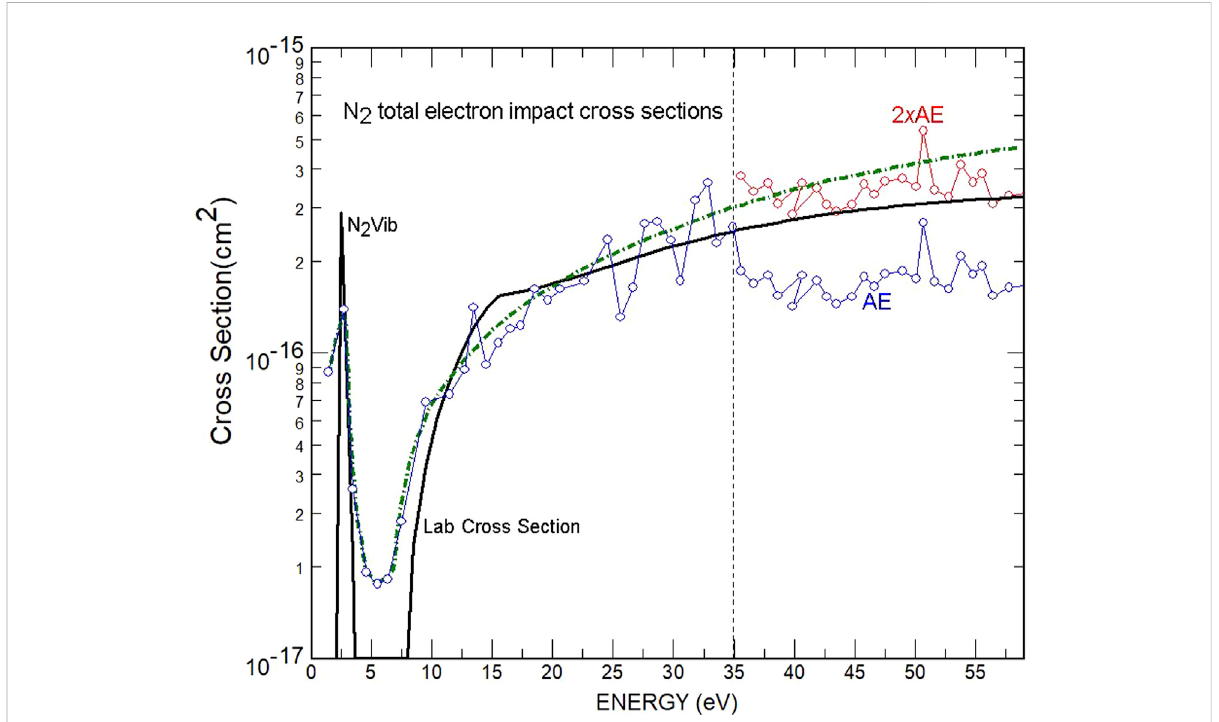
Comparison of N 2 cross-sections derived from Atmosphere Explorer solar EUV irradiance and photoelectron fl ux (AE) with Laboratory cross- section(solid line). Thedash-dotlineisaweightedleast-squares fi ttothe1.0xAEdata points below35 eV. Thepoints labeled2 x AEwereobtained by doubling the AE values. The label N 2 Vib identi fi es the cross-section peak near 2.5 eV that results from vibrational excitation of N 2